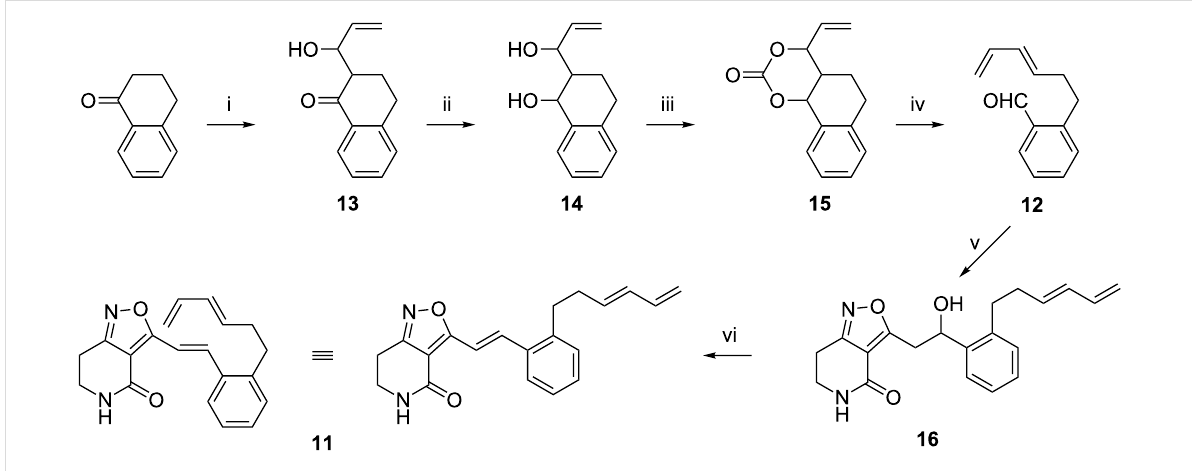
Scheme 3: Synthesis of triene 11 . Reagents: (i), LDA, propenal, THF, − 78 °C; (ii), LiAlH 4 , THF, 20 °C (75%); (iii), MeOCOCl, Et 3 N, CH 2 Cl 2 (74%); (iv),